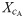
Relationships of cranio-caudal/medio-lateral navicular displacements (NCC/NML) to forefoot to hindfoot (FFtoHF) rotations.(a) Averages among participants with standard deviations for FFtoHF plantar/dorsiflexion, adduction/abduction and pronation/supination during the stance phase (SP). Corresponding ranges of motion are given in Table 2. The blue parts represent the absorption and the red parts the generation phases. (b), (e) Displacement-displacement diagrams of mean FFtoHF rotations versus mean NCC (b) and mean NML (e) with median cross-correlation coefficients for the whole stance phase (Xc), the absorption phase (XcA) and the generation phase (XcG) in the titles. (c), (f) Scatter plots of cross-correlation coefficients for the whole stance phase (Tot), the absorption phase (Abs) and the generation phase (Gen) from all participants for the relationships presented in rows 2 and 4. Large markers represent the medians. (d), (g) Distribution of the cross-correlation coefficients among the strong, moderate and weak classes (values given in Table 3).